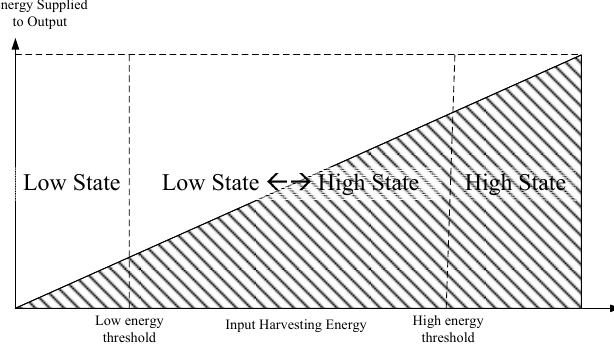
Figure 5. State classification for the harvest energy input.